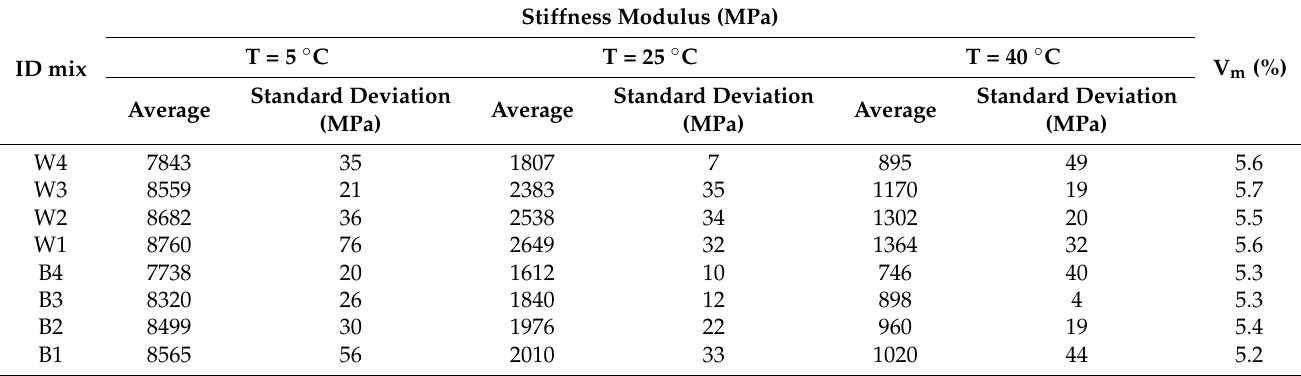
Table 6. Average values of stiffness modulus (S) at 5 ◦ C, 25 ◦ C, 40 ◦ C and void